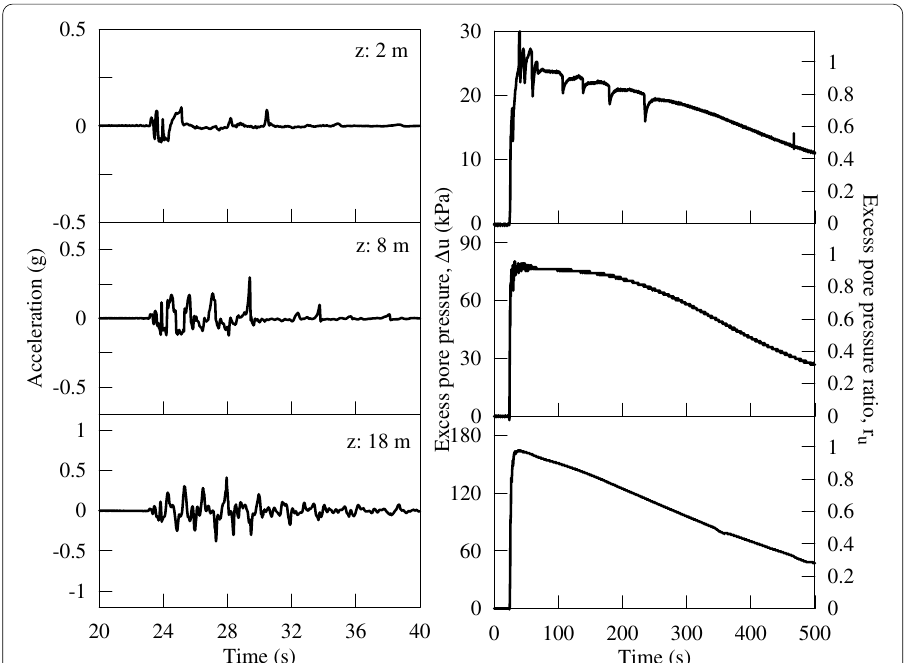
Fig. 3 The measured acceleration and excess pore pressure time histories at different depths during the Kobe‑L